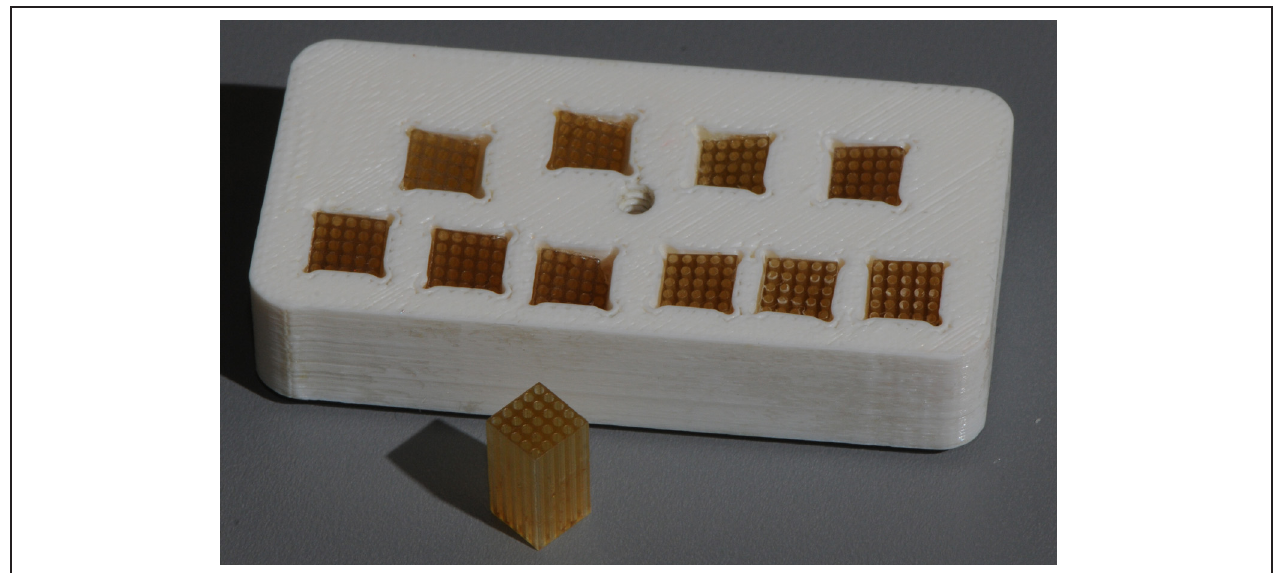
FIGURE 6 | The 5 × 5 × 10mm insert. Each insert contained 25 holes (diameter: 635 micron; 1mm on center). Final master grid with 10 inserts each aimed at a specific ROI.